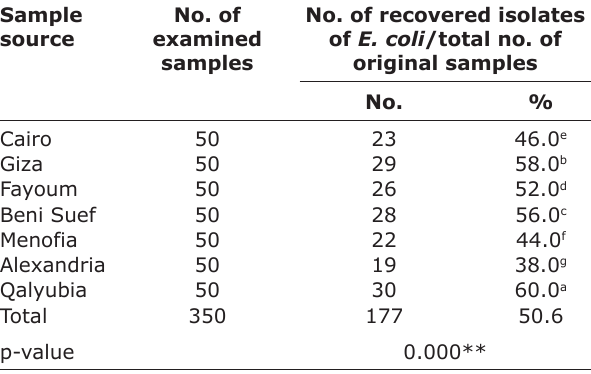
Table-6: Prevalence rates of E. coli isolates in meat and meat by-products.